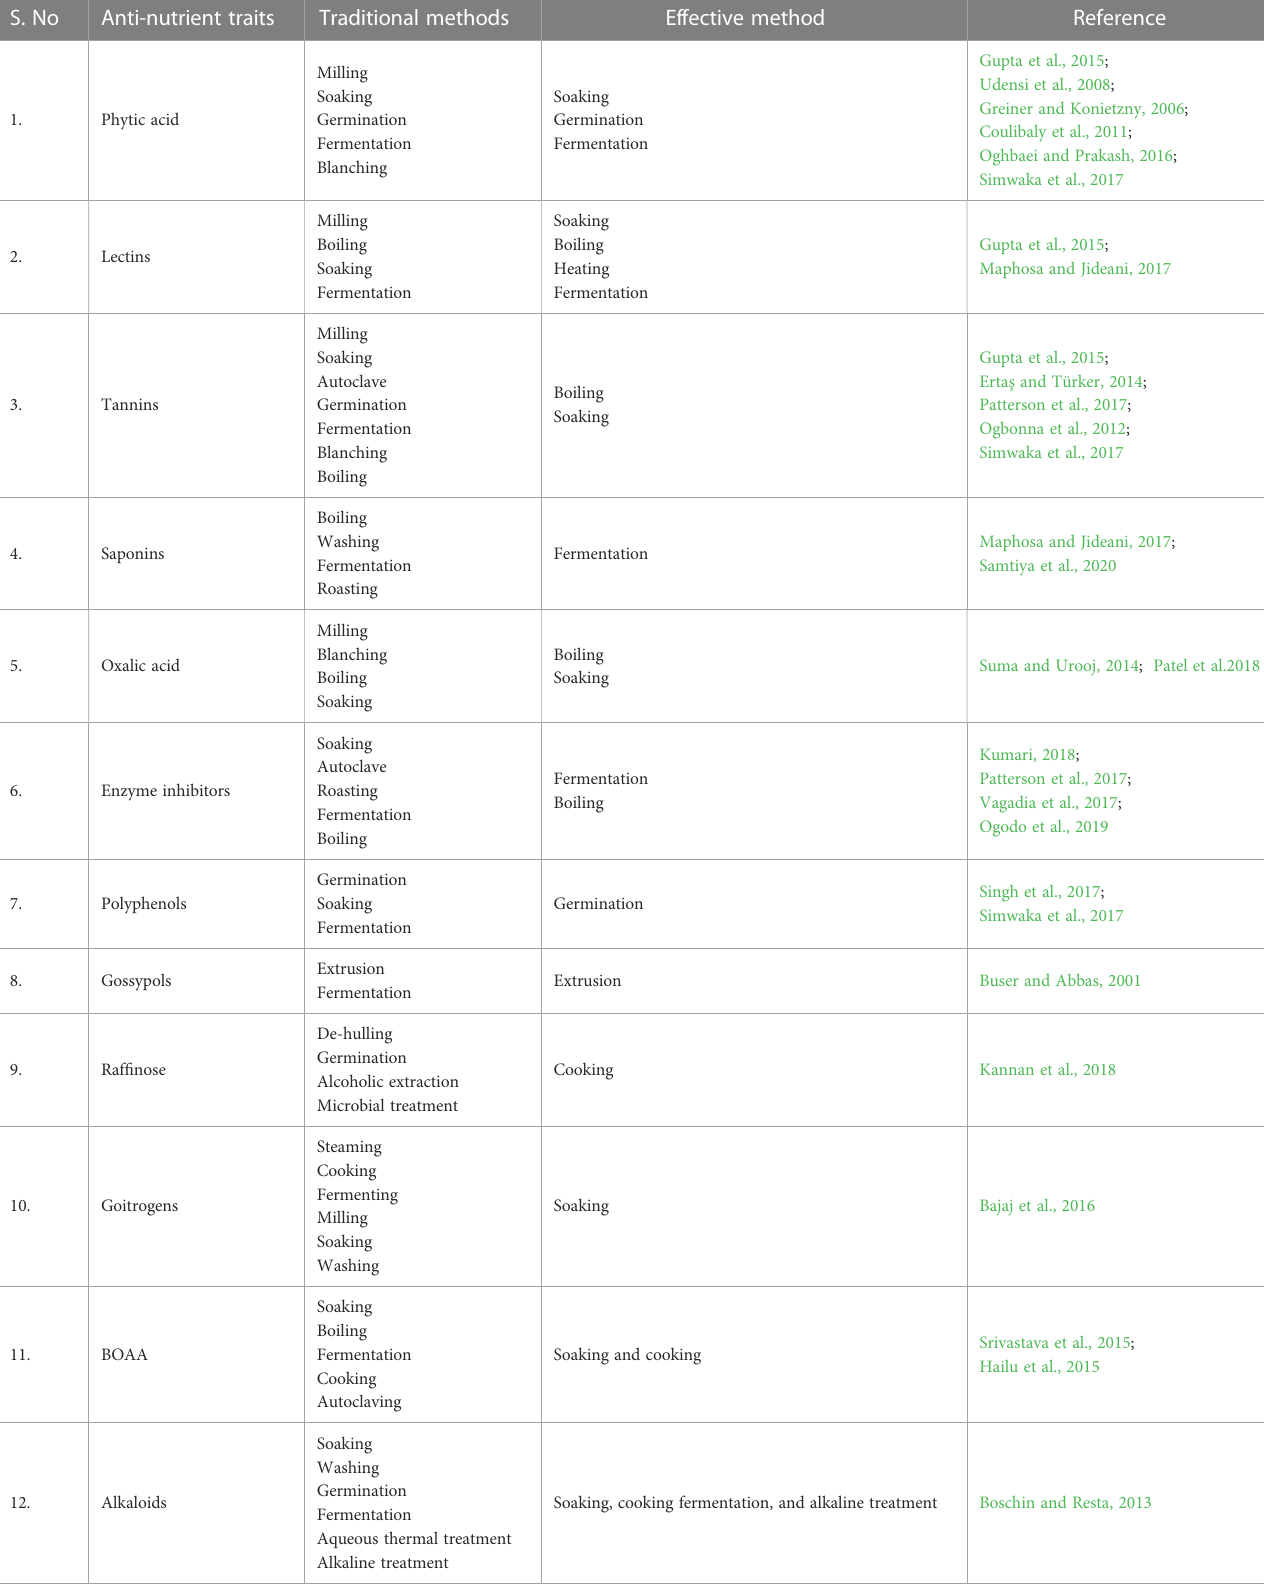
TABLE 2 Effect of different processing techniques to minimize the anti-nutrients in